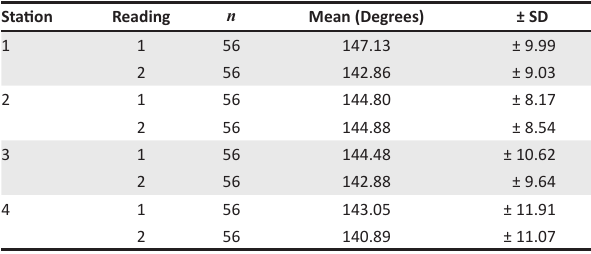
TABLE 3: Descriptive statistics of Readings 1 and 2 per station.